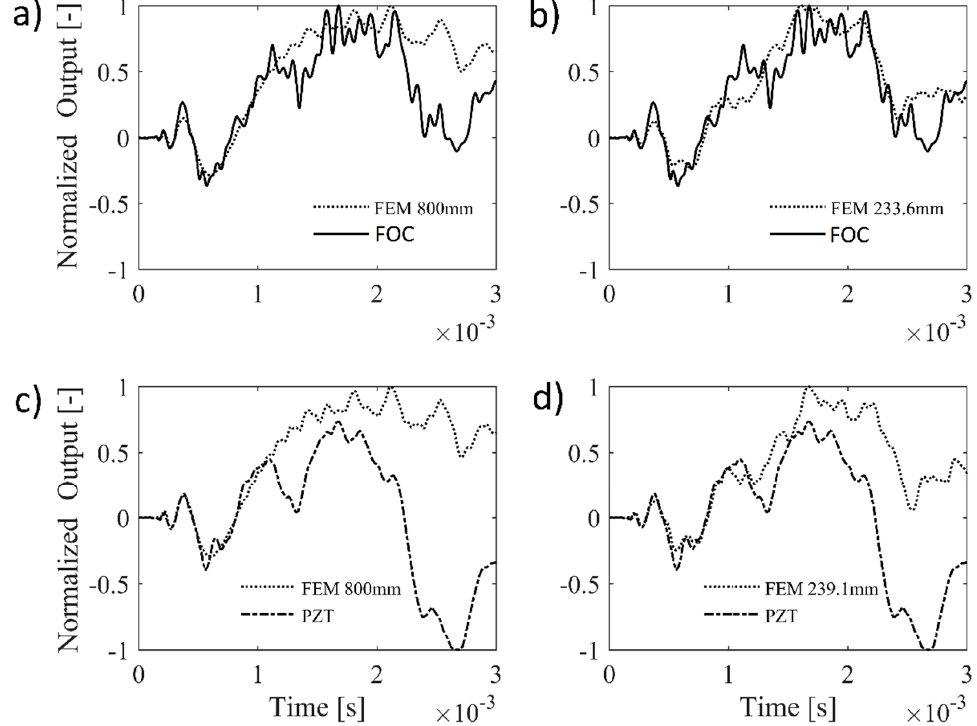
Figure 12. Comparison of FOC ( a , b ) and PZT ( c , d ) sensors vs. FEM simulated signals after an impact event. On the left ( a , c ), no strain wave reflection is included in the FEM approximation. On the right ( b , d ), FEM is designed to account for first boundary reflections.